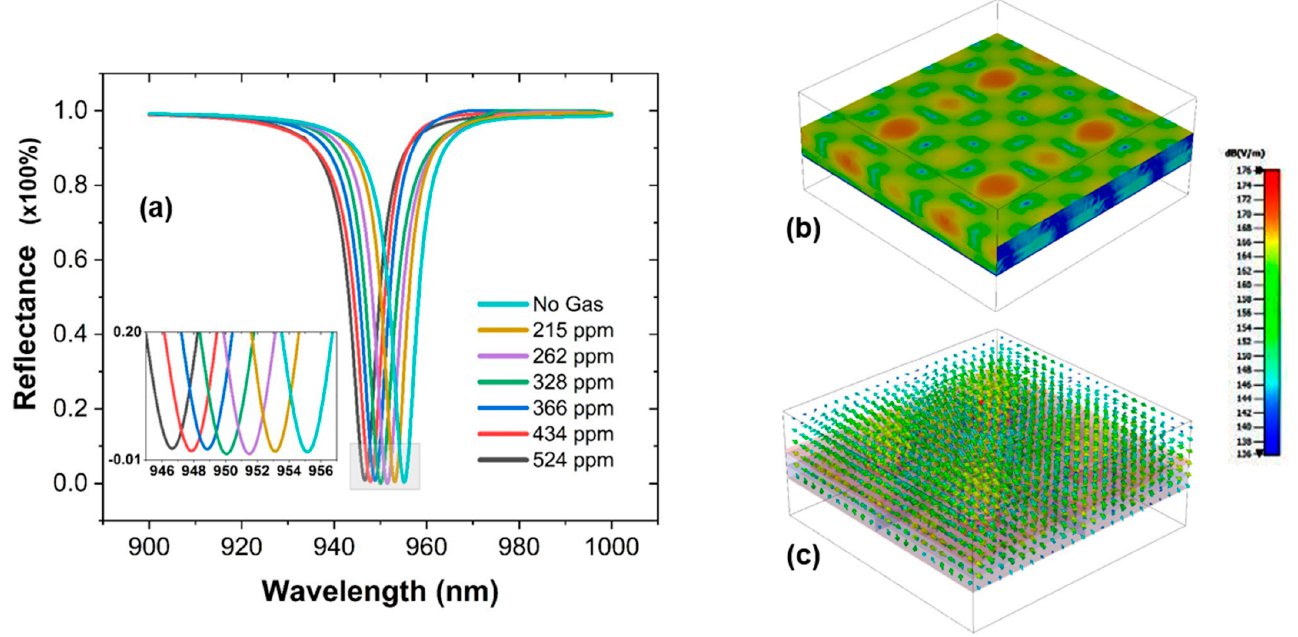
Figure 5. ( a ) Output reflection spectra, presenting a blue shift in the resonant wavelength λ res of the sensor sensing different concentrations of the CO 2 gas. ( b ) Plasmonics effects on the surface of the sensor. ( c ) Energy con fi nement by the sensor.